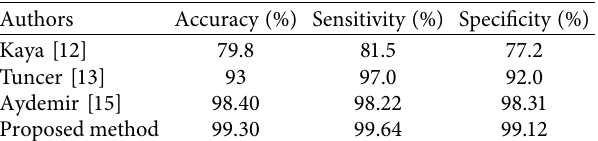
Table 8: Comparison of the proposed method with the state-of- the-art methods for fve-class scenario using University of Bonn database (Case